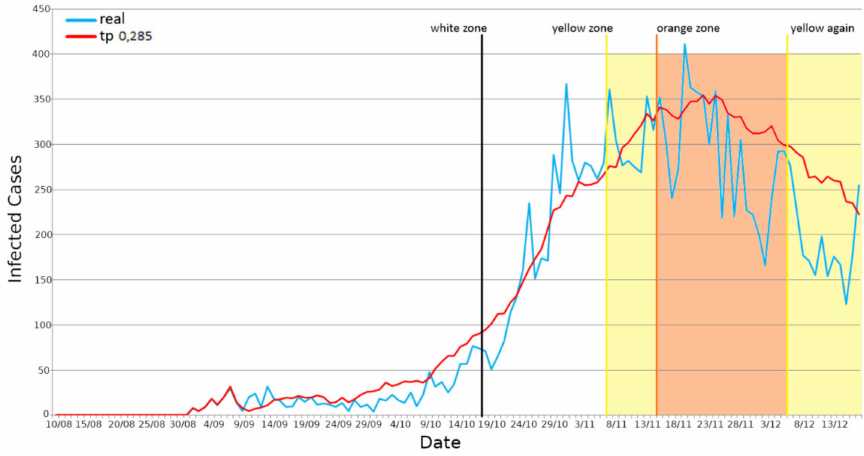
Figure 10. Positives’ daily representation—Reggio Emilia province, Emilia Romagna region.